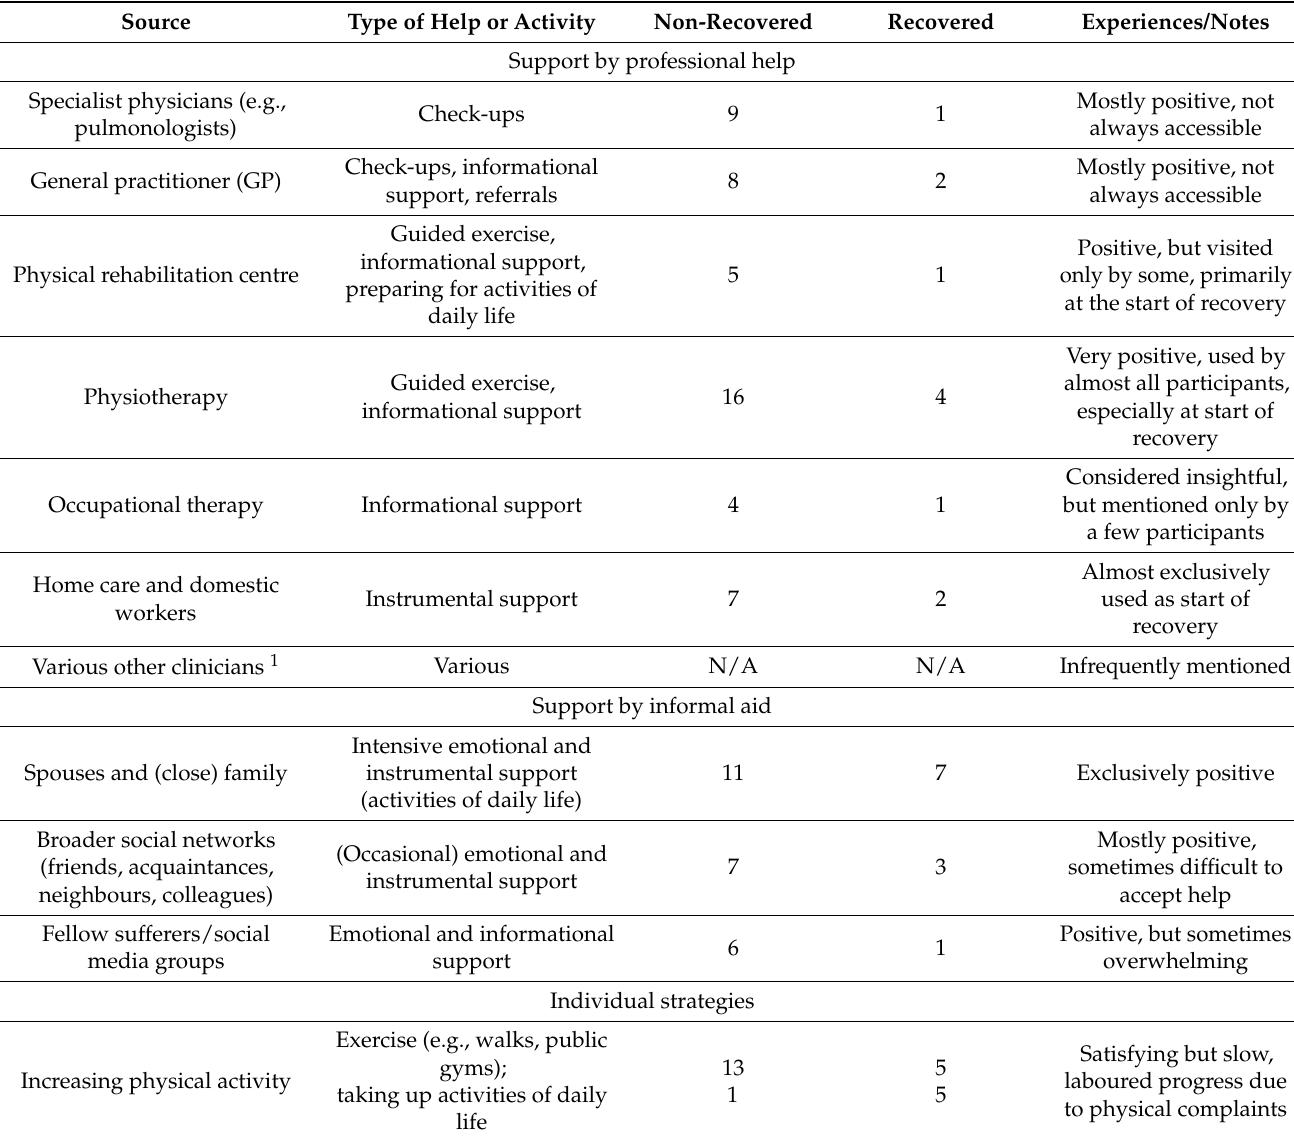
Table A1. Overview of Recovery Strategies Employed by Non-Recovered ( N = 16) and Recovered Participants ( N =